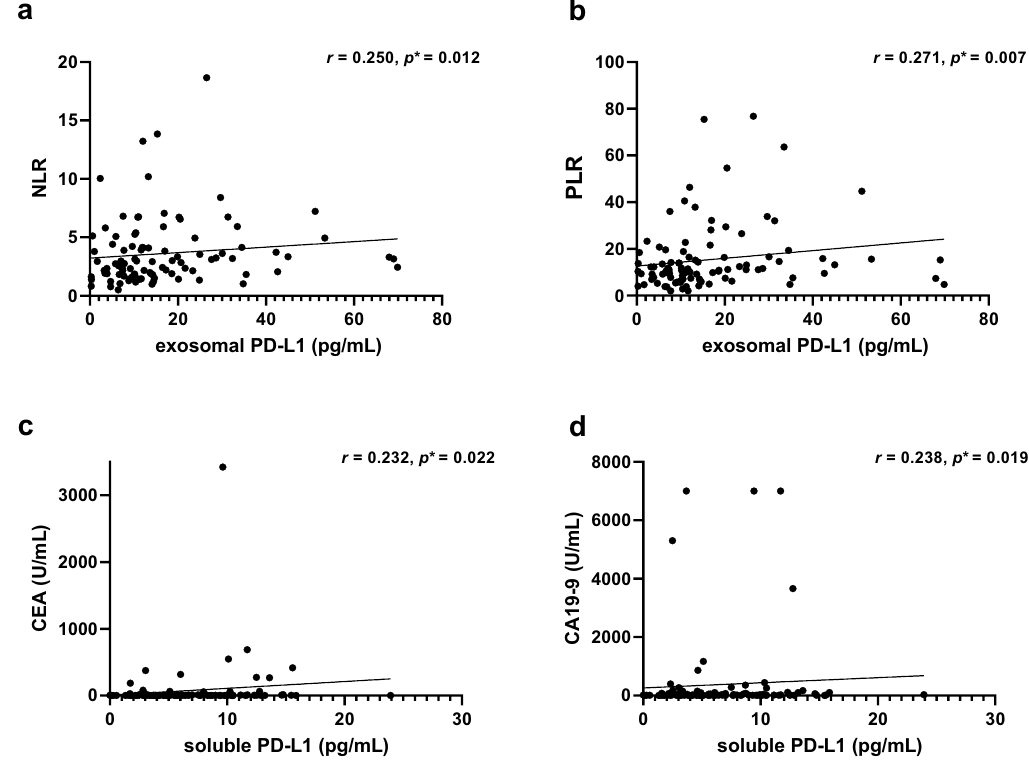
Figure 3. Correlation between exoPD-L1 and systemic inflammatory makers. ( a , b ) exoPD-L1 was positively correlated with NLR (Spearman’s ρ = 0.250, p = 0.012) and PLR (Spearman’s ρ = 0.271, p = 0.007). Correlation between sPD-L1 and tumor markers. ( c , d ) sPD-L1 was positively correlated with CEA (Spearman’s ρ = 0.232, p = 0.022) and CA 19-9 (Spearman’s ρ = 0.238, p =